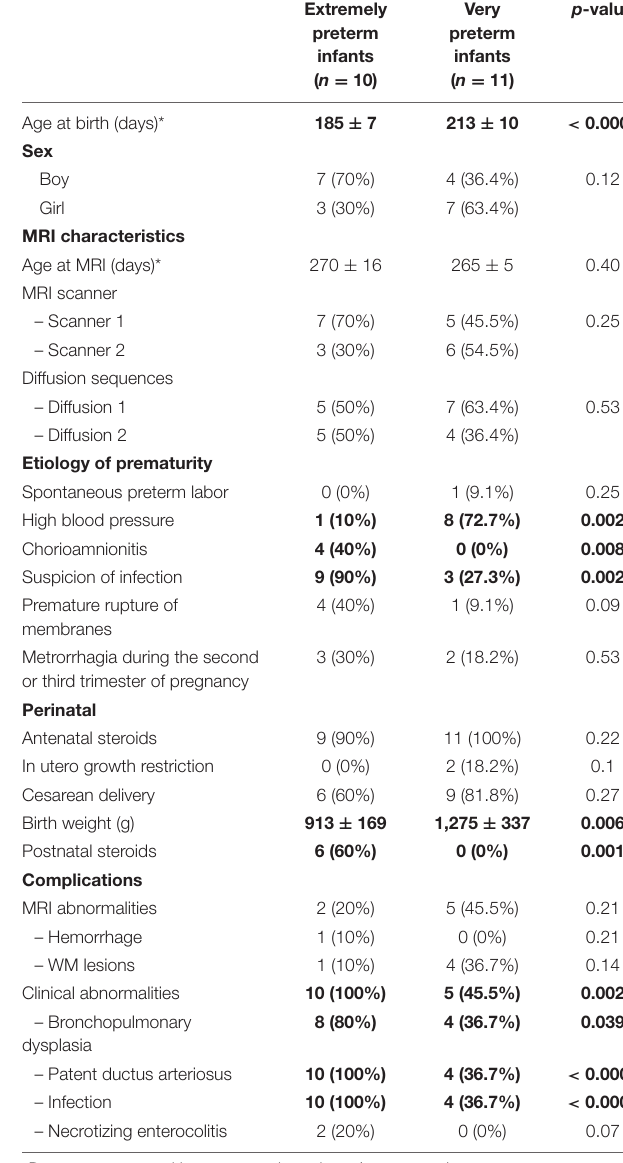
The absolute whole brain volume was not significantly different in preterm boys than in preterm girls (340.98 ± 49.7 ml versus 298.32 ± 25.9 ml, p = 0.23) ( Figure 3C ). The absolute insular volume was the only volume that was significantly related to the sex ( p = 0.04). Regarding the other absolute volumes and the relative volumes, we did not find any other significant relation between sex and any of the tested ROIs. The scanner type had no significant effect on the absolute whole brain volume (308.1 ± 53.7 ml versus 325.7 ± 27.8 ml, p = 0.30) ( Figure 3D ), nor on the absolute GM or WM volumes (respectively p =